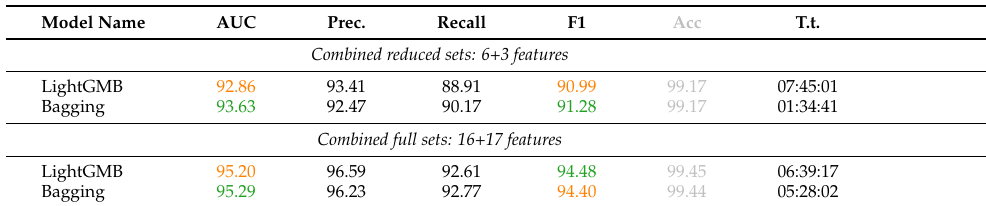
Table 8. Results on the combined feature sets. Best and worse AUC and F1 scores are shown in green or orange text, respectively.